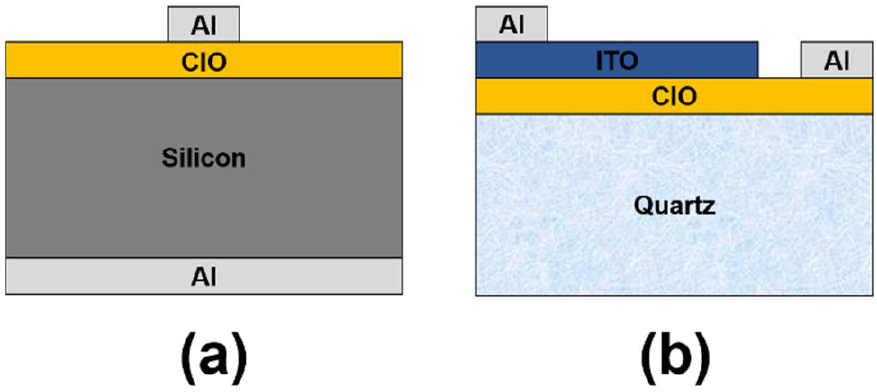
Figure 1. Device schematic for ( a ) n-Si/p-CIO heterojunction and ( b ) quartz p-CIO/n-ITO hetero- junction.